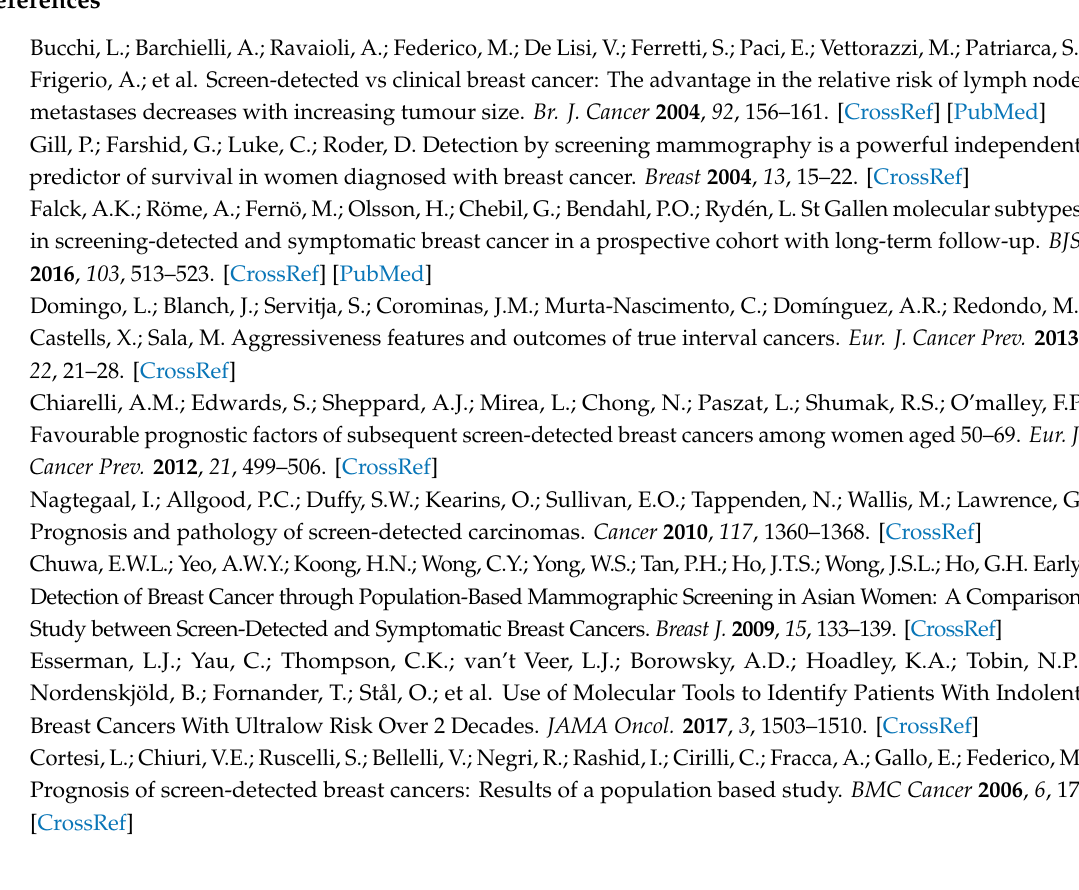
Table S1: Disease-free survival in the age range 50–69-year-old, Table S2: Concordance analysis between HER2 status in both hospitals, Table S3: Ki67 di ff erences between the subrogate phenotypes in the series (NSDBC and SDBC) (PDP), Table S4: Cox model for histopathologic features for disease-free survival and cancer-specific free survival within the HER2-positive breast cancer tumors, Table S5: Antibodies, Table S6: HER2 fluorescence in situ hybridization (FISH) used in PDP and